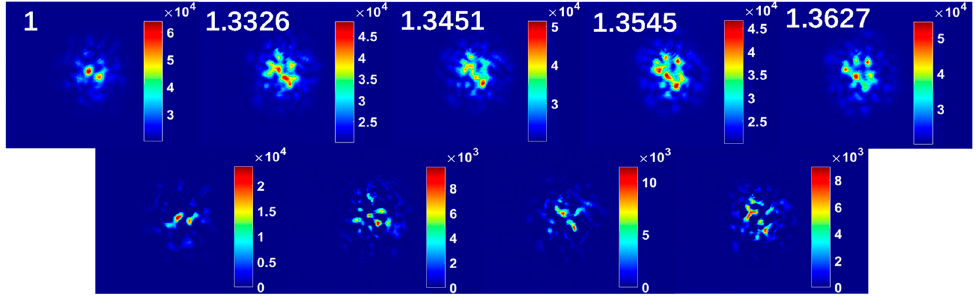
Figure 3. Speckle patterns corresponding to different refractive indexes and their differences be- tween the adjacent speckle patterns.